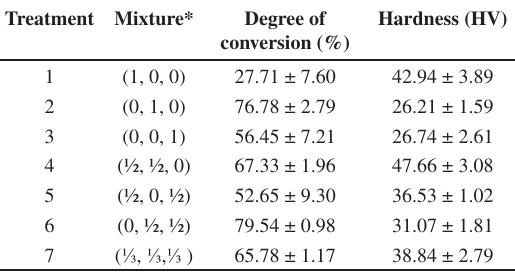
Table 1. Mean degree of conversion and Vickers hardness obtained by simplex-centroid experimental design of the mixture composition.